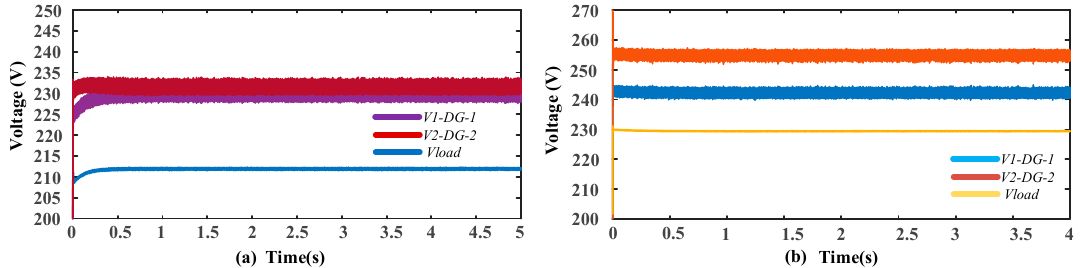
Figure 9. ( a ) Inverter terminal and load voltages for the conventional control strategy; ( b ) inverter terminal and load voltages for proposed control strategy.